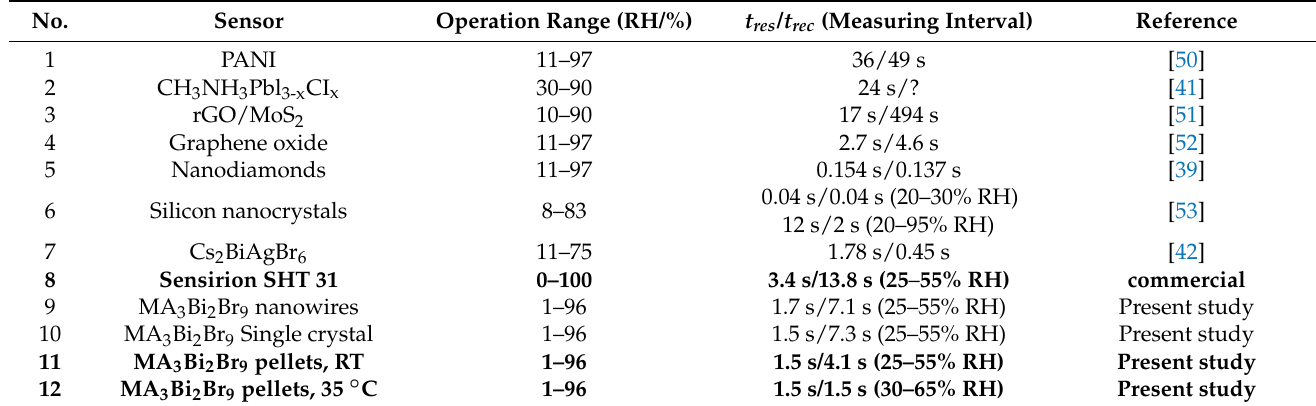
Table 1. Comparison of several recent humidity sensors.